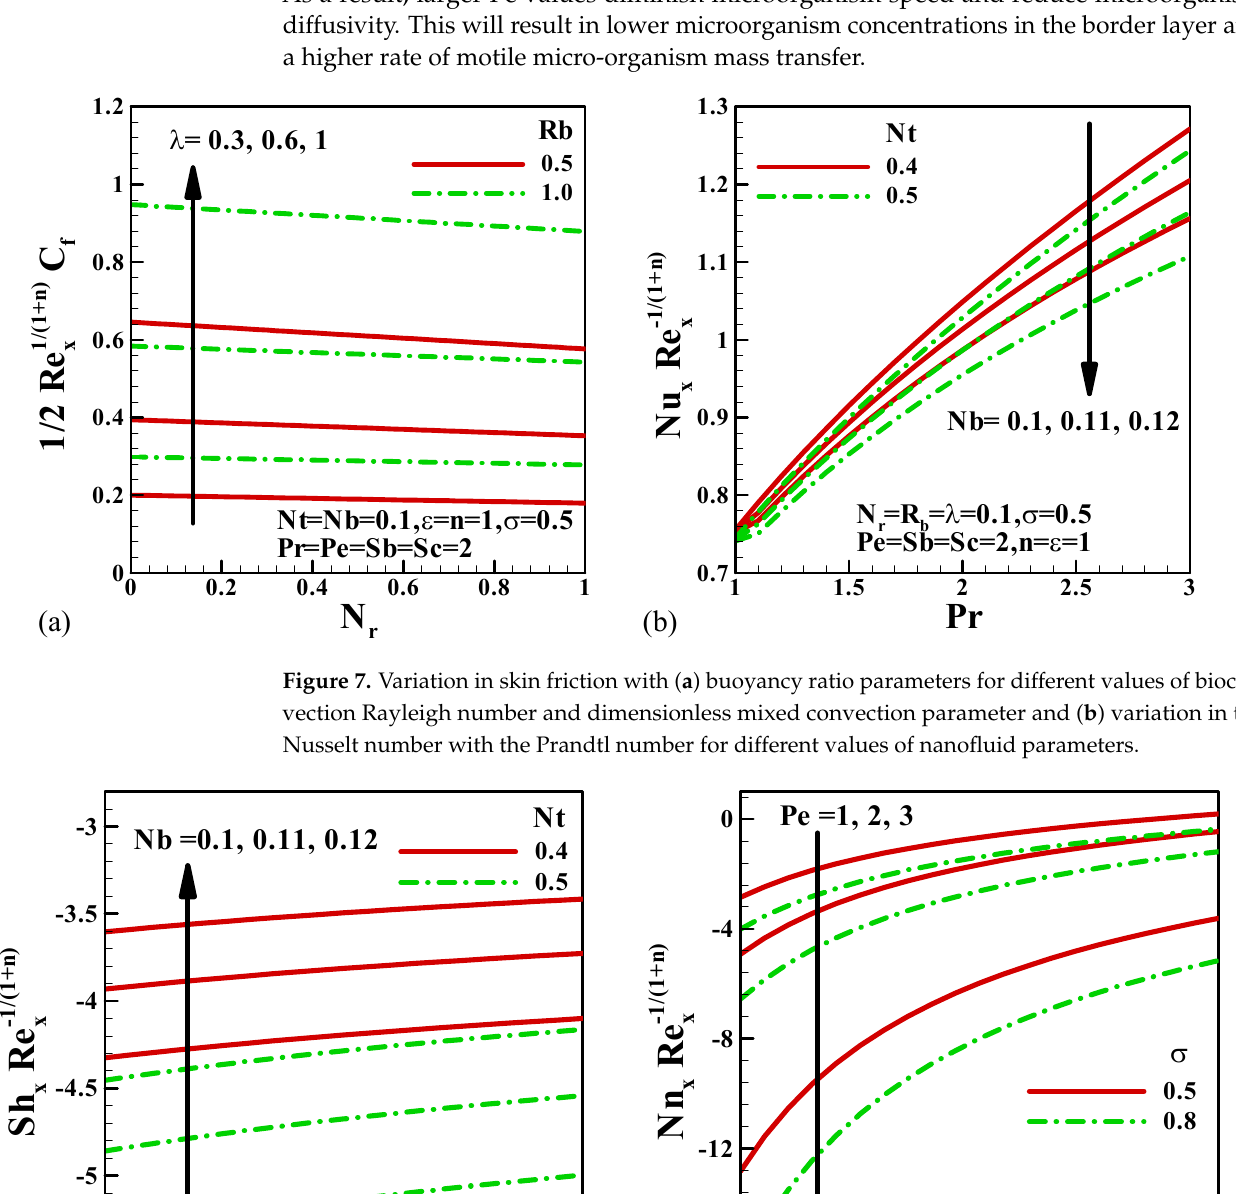
11 of 15 Figure 6. Variation of dimensionless motile micro ‐ organism density with ( a ) the bioconvection Schmidt number with different Peclet numbers and ( b ) the bioconvection constant and Brownian motion parameter. For several values of the bioconvection Rayleigh number and dimensionless mixed convection parameter, the variation in skin friction with the buoyancy ratio parameter is shown in Figure 7a.The skin friction is observed to rise with the bioconvection Rayleigh number and dimensionless mixed convection parameter, but decreases slightly with the buoyancy parameter. The skin friction is exceptionally high in the absence of the buoyancy effect and subsequently tends to decrease along with the buoyancy parameter. However, compared with buoyancy force convection, increasing the bioconvection Rayleigh num ‐ ber and dimensionless mixed convection parameter enhanced the convection heat. These results are anticipated; in the interim, heat is produced as a result of increased skin fric ‐ tion, resulting in the formation of a layer of hot fluid close to the surface. It is interesting to note that, as long as skin friction values are positive, we can see that drag force is im ‐